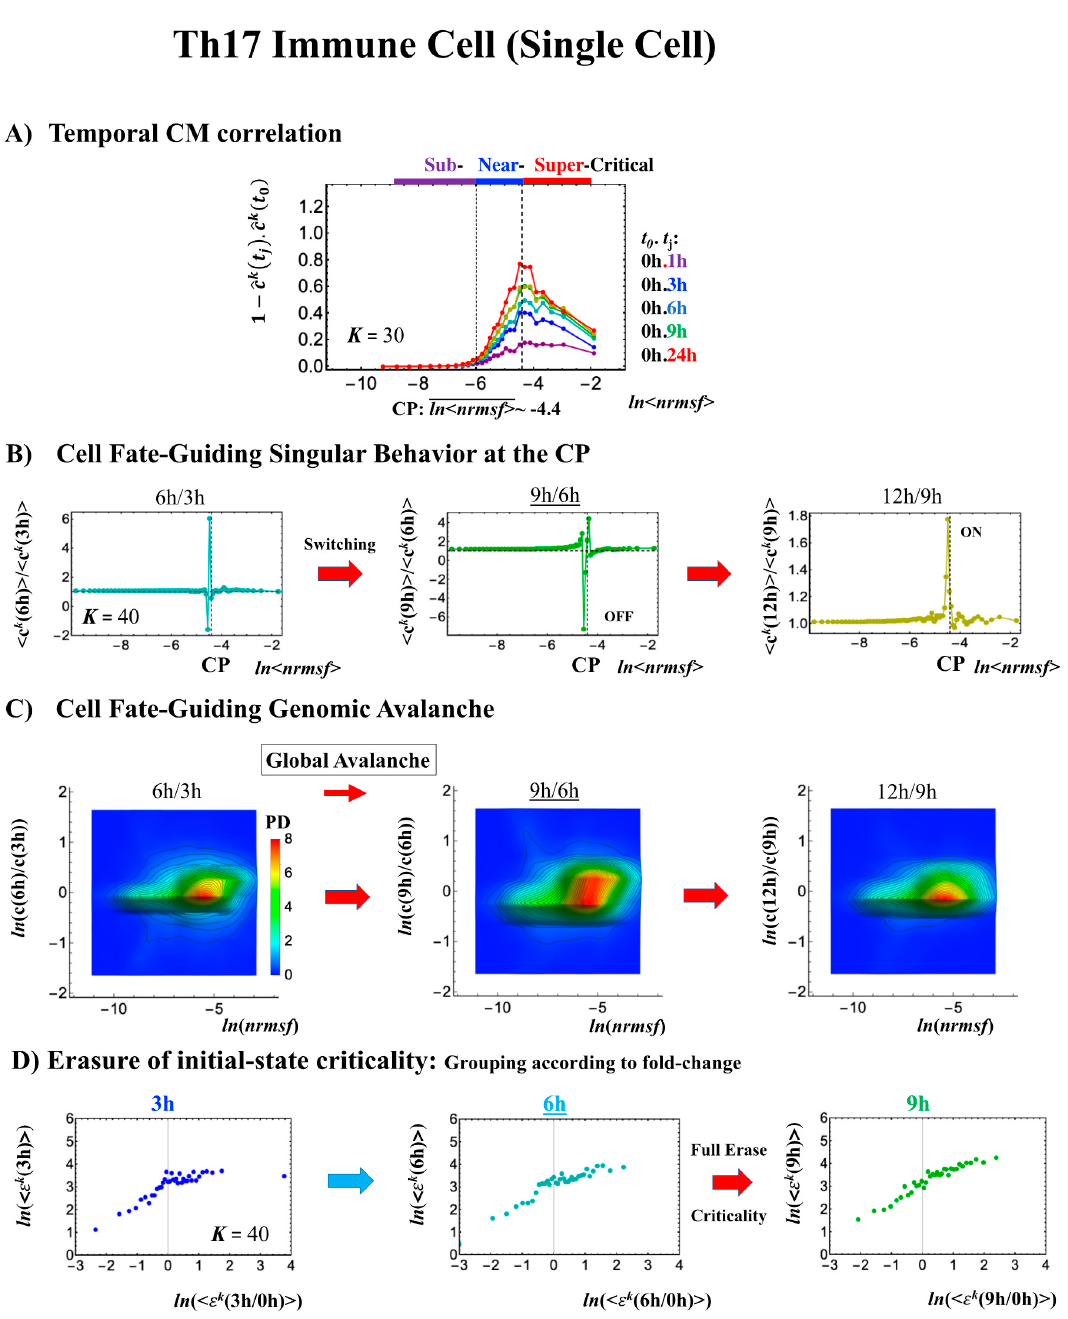
Figure 9. Di ff erentiation of Th17 immune cells from Th0 cells (single-cell). ( A ) The CP features are the same as in the embryo cases; the only di ff erence is that the CP never passes the zero-temporal correlation ( K = 30, n = 437 RNAs). ( B ) The switching singular transition ( K = 40: n = 328) at the CP (genome attractor) occurs from 3 to 9 h through 6 h, which induces ( C ) a large-scale (but not whole-genome as in the embryo cases) expression avalanche: swelling of the density profile from 3–6 h, and then contraction at 9–12 h. The timing of the cell-fate change (di ff erentiation of Th17 cells from Th0) after 6 h is demonstrated by ( D ) erasure of the initial-state ( t = 0) criticality. This timing is further supported by the same timing as in the switch from suppression to enhancement of the genome engine (see Section 3.1). The sensitivity of singular transition at the CP is observed according to the number of groups.